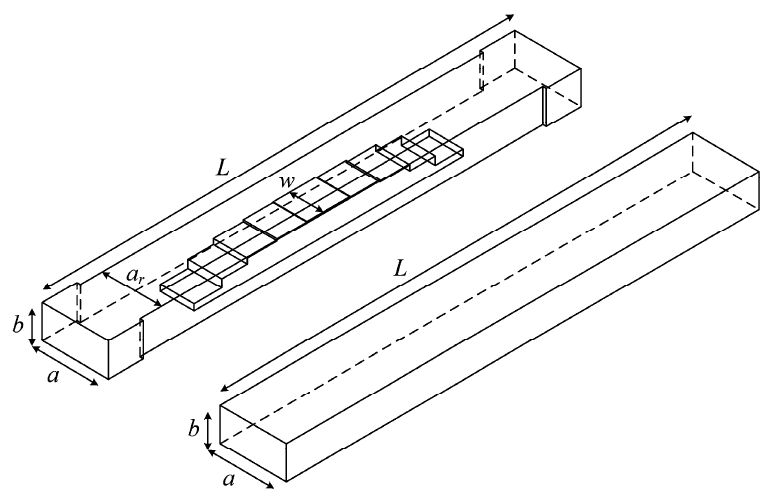
Figure 1. 3D sketch of the generic ridge waveguide differential phase shifter: shift and reference waveguides.